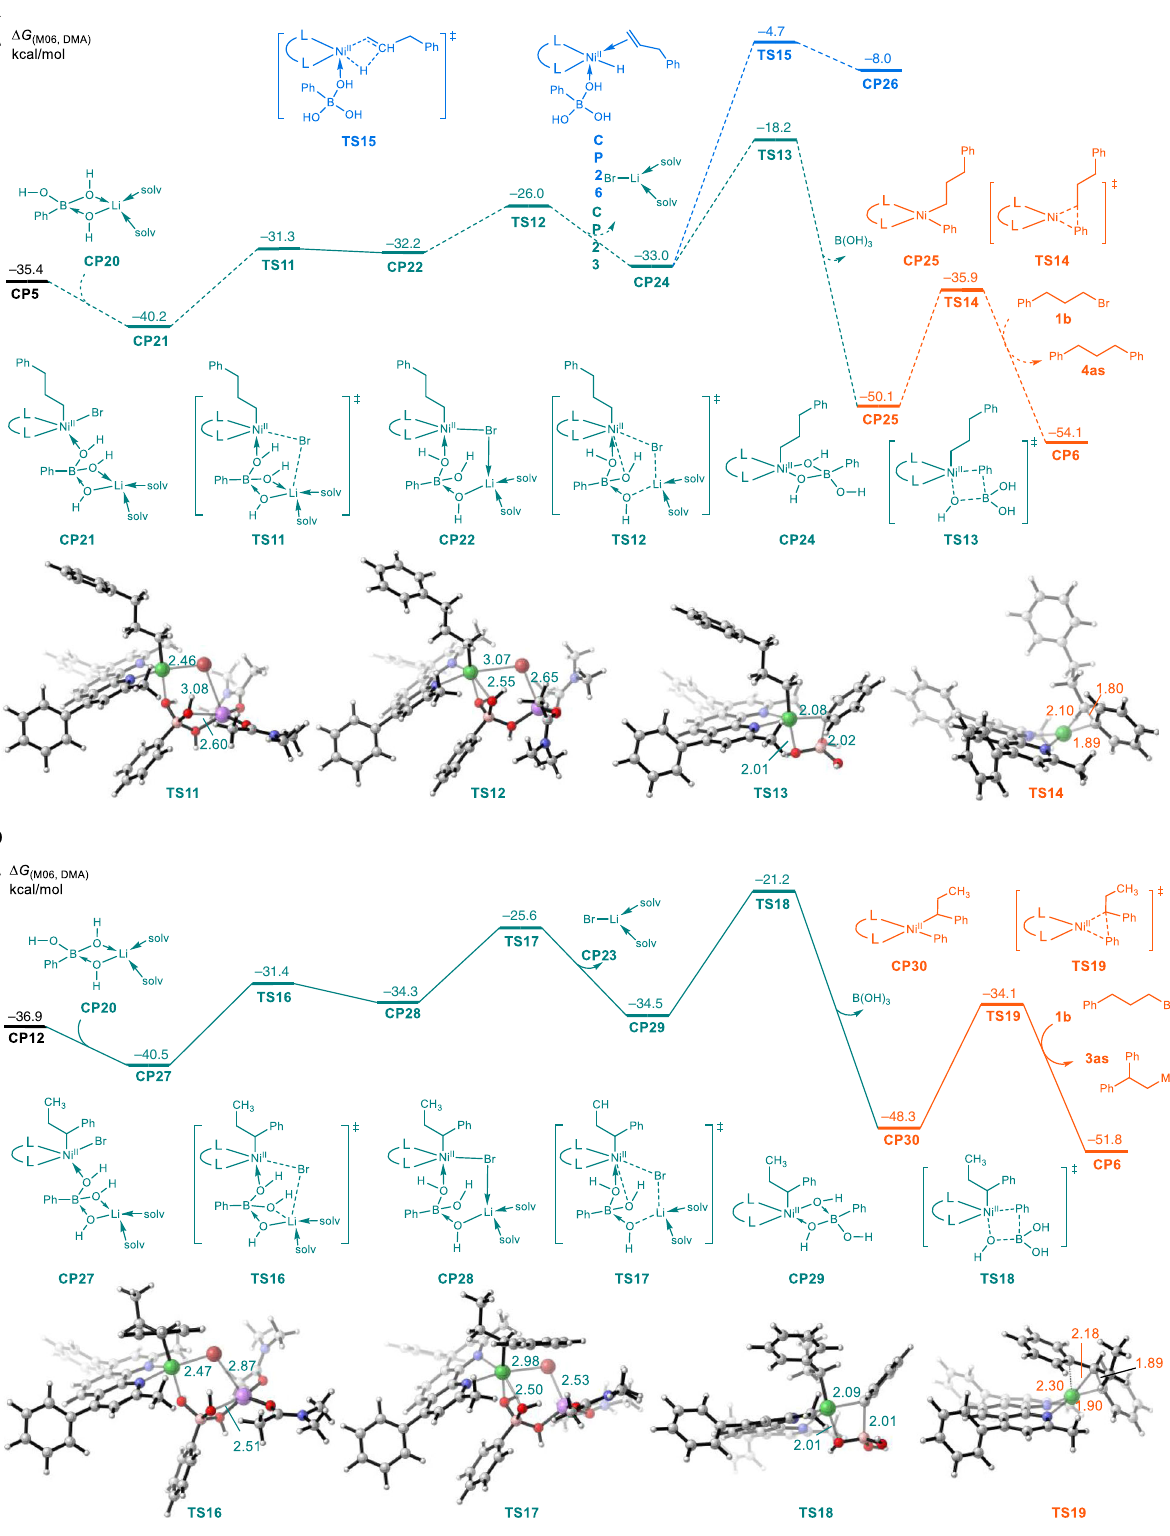
Fig. 8 Calculated reaction energy pro fi le. a Chain-walking and original-site product formation process. Energy values are given in kcal/mol and represent the relative free energies calculated by the M06 method in N , N -dimethylacetamide. The values of bond length are given in ångstrom. b migratory product formation process. Energy values are given in kcal/mol and represent the relative free energies calculated by the M06 method in N , N -dimethylacetamide. The values of bond length are given in